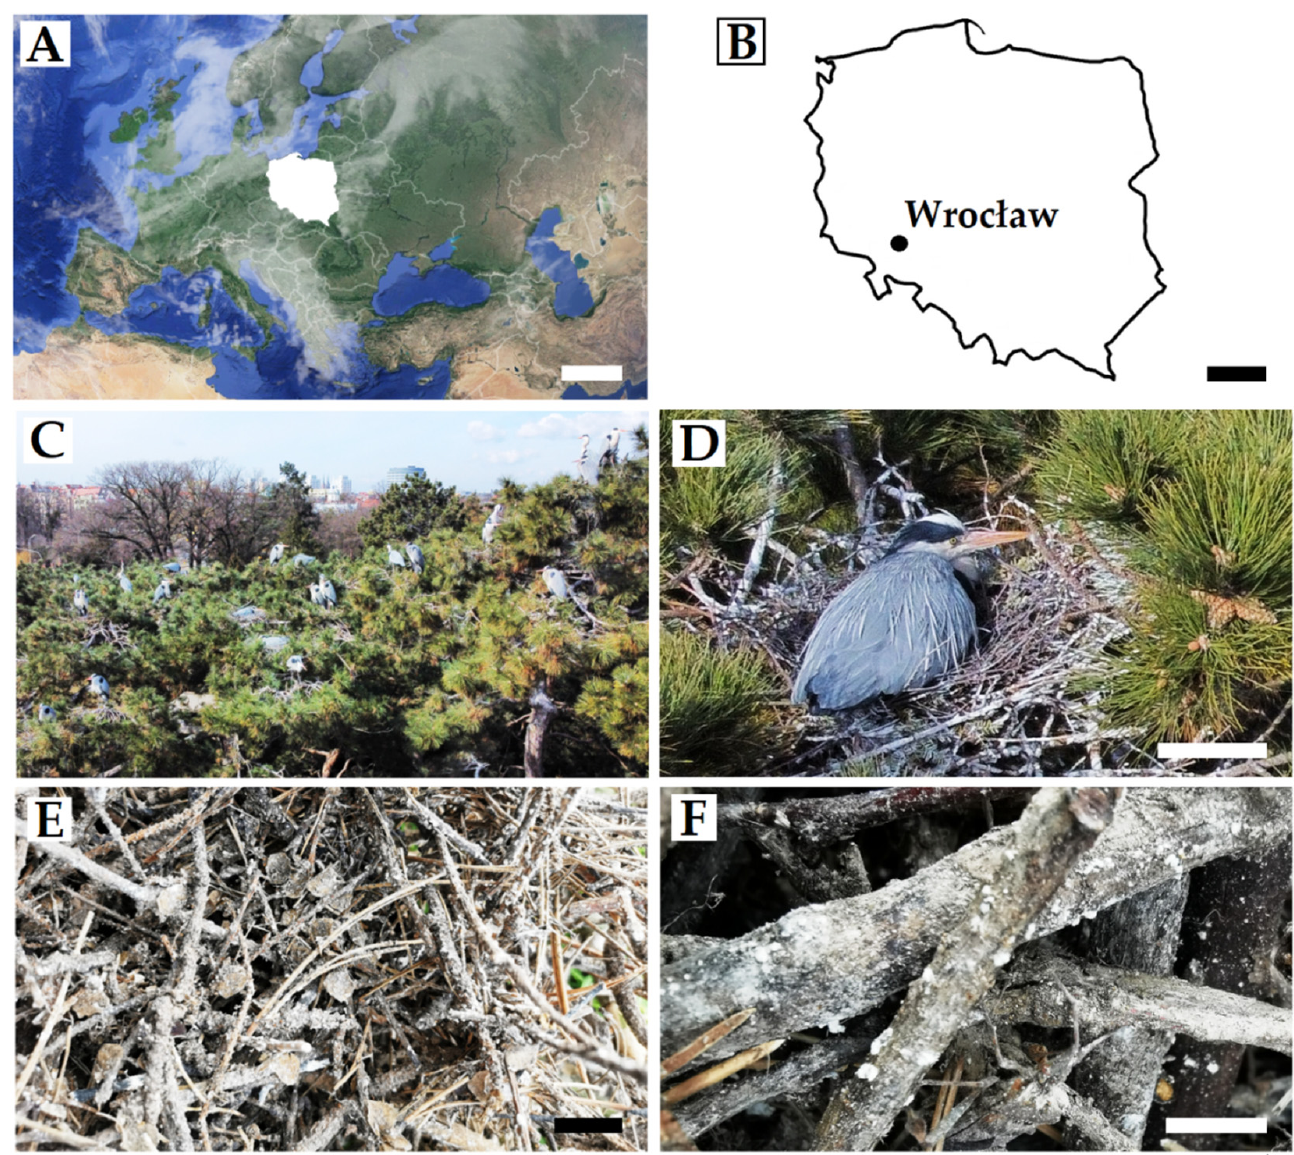
Figure 1. Geographic location of Poland ( A ) and the city of Wrocław ( B ). Grey heron breeding colony viewed from above ( C ), and close-up of female individuals in the nest ( D ). Nests with visible fungal growth ( E , F ). Scale bars: A = 500 km, B = 100 km, D = 20 cm, E = 1 cm, F = 5 mm.